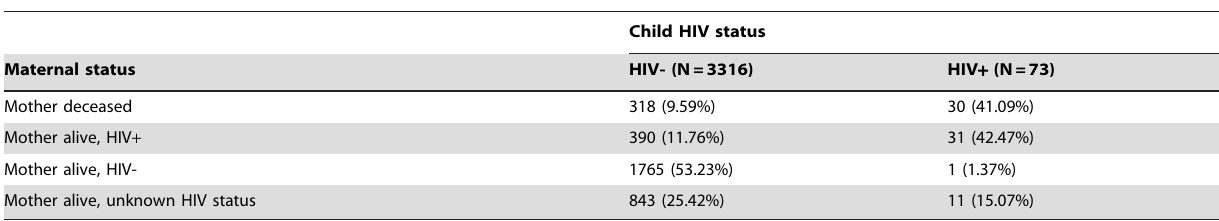
Table 2. Maternal mortality and HIV status in children.